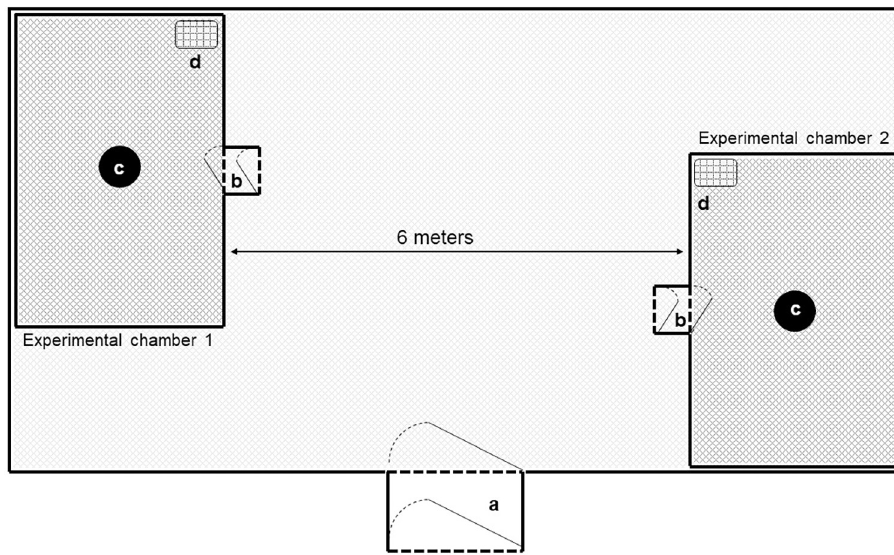
Fig 1. Illustration of the experimental chambers inside the semi-field facility, showing: a) Entry into the main chamber; b) Entries into the experimental cages; c) Volunteer stations and d) Mosquito release points.